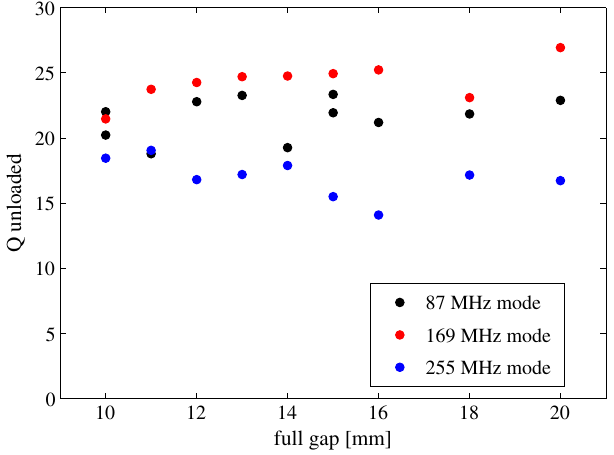
FIG. 10. Dependence of the unloaded Q versus jaw full gaps for the first three low frequency resonant modes.